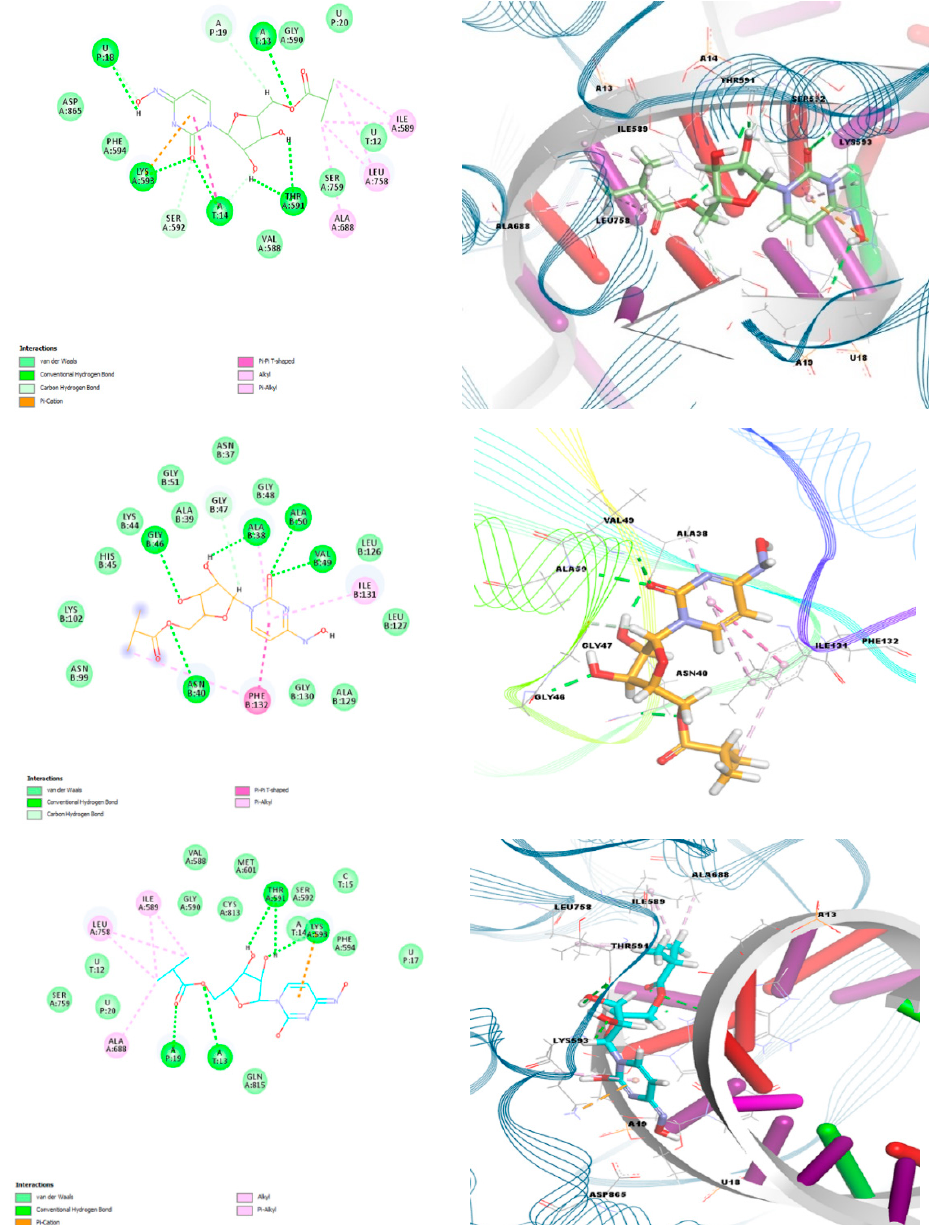
Figure 8. Two-dimensional ( left ) and 3D ( right ) views on the interaction of the keto-oxime ( top ), keto-hydroxylamine ( middle ), and hydroxyl-oxime ( bottom ) tautomers of molnupiravir with (from top to bottom) RdRp-RTR, Nonstructural protein 3 (Nsp3_range 207–379-MES) and RdRp-RTR.